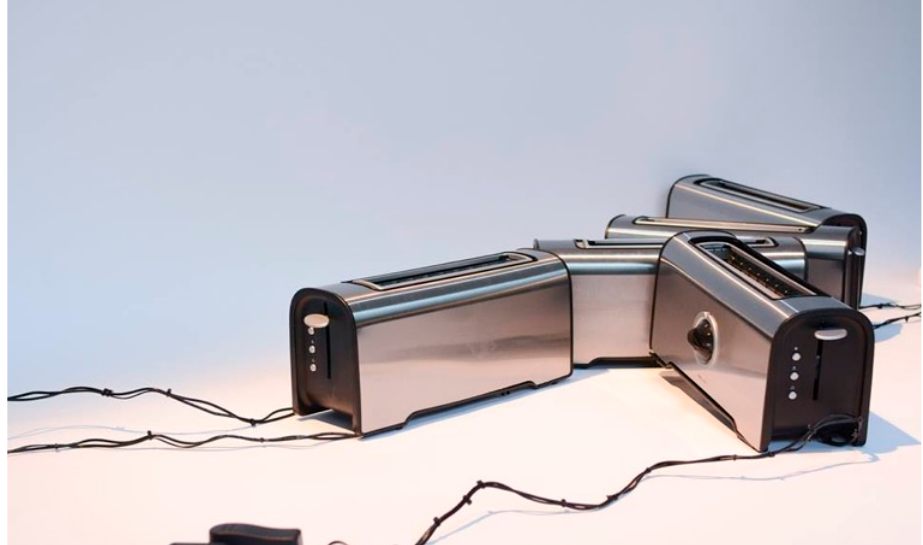
Figure 8. Toasters , Installation by Olivain Porry at Cité des Arts, Paris, 2018. Photo: Amélie Canon.